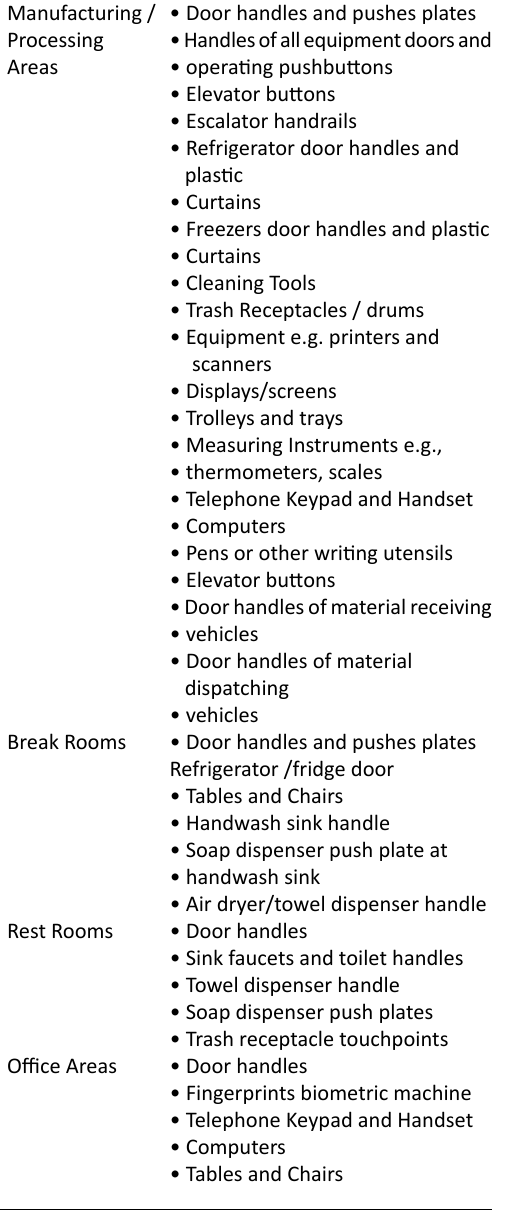
Table 1. List of most common and frequent touchpoints